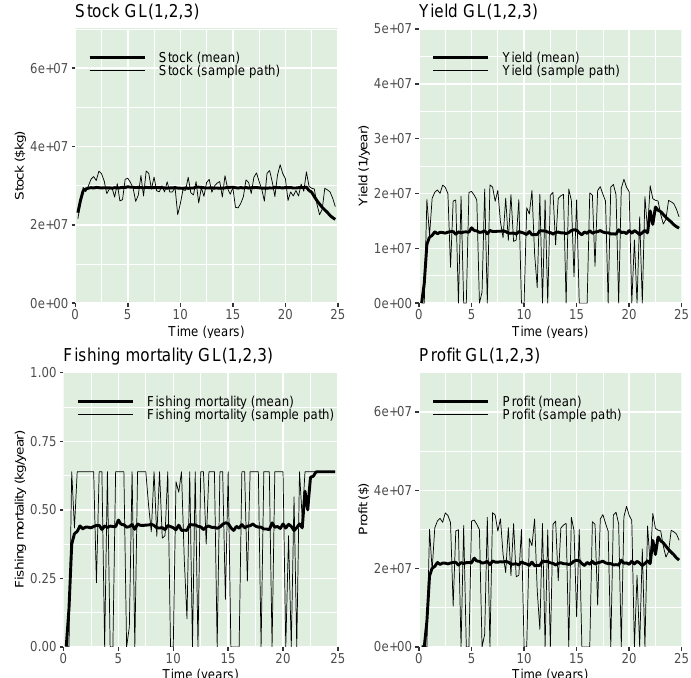
Figure 4. Stock, fishing mortality, yield, and profit sample paths (thinner line) and mean (ticker line) obtained by the application of model GL ( 1,2,3 ) . Unit values are described in Table 1.